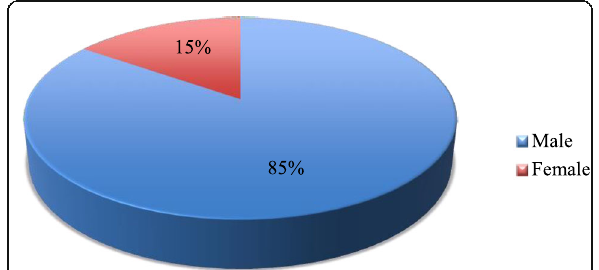
Fig. 1 Distribution based on gender